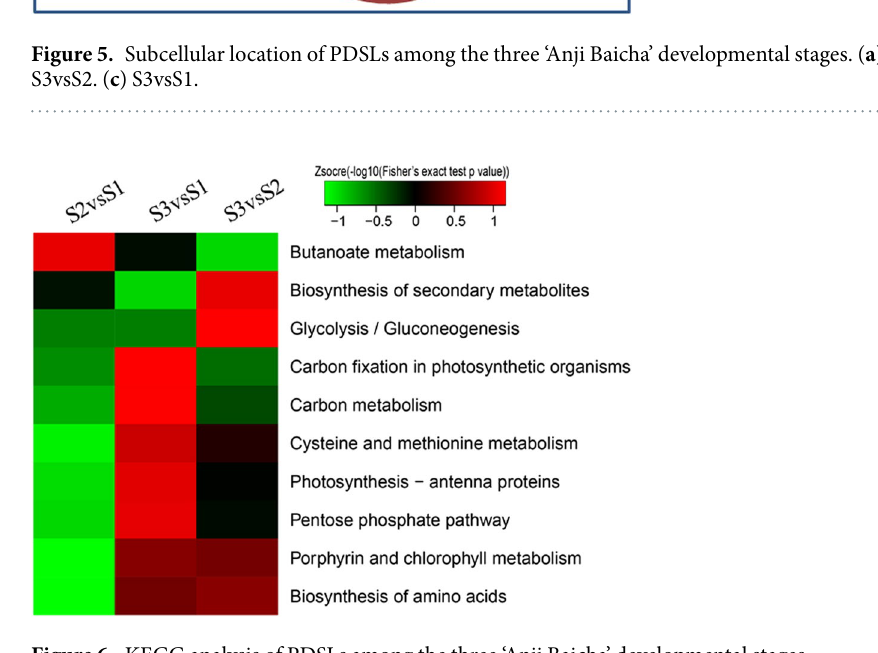
Figure 6. KEGG analysis of PDSLs among the three ‘Anji Baicha’ developmental